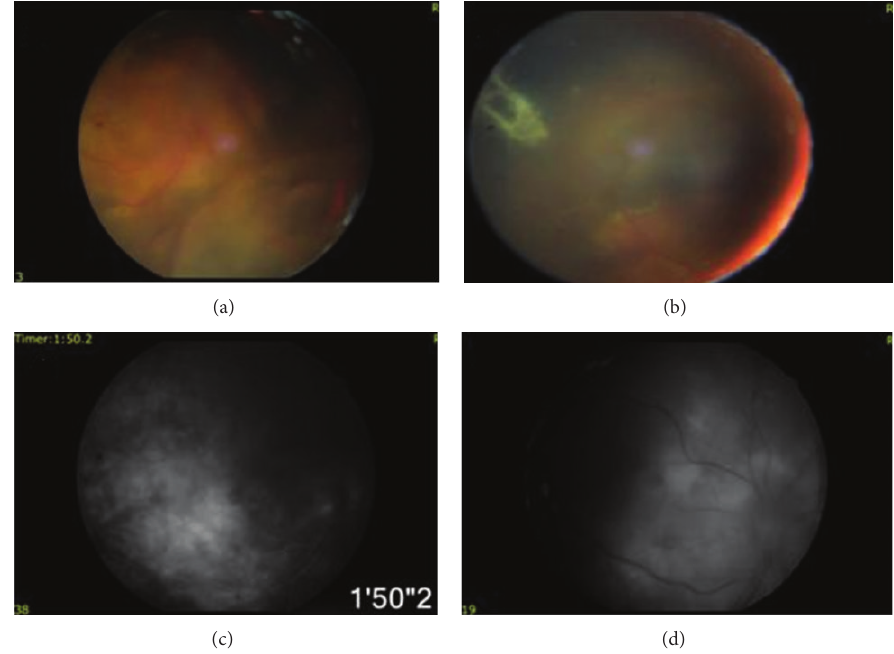
Figure 4: After cataract surgery, funduscopic examination revealed severe vitreoretinopathy (a) and choroidal hemangioma (b) in the right eye. Fundus fluorescein angiography demonstrated leaking from dilated retinal vessels (c), ischemia, and neovascularization